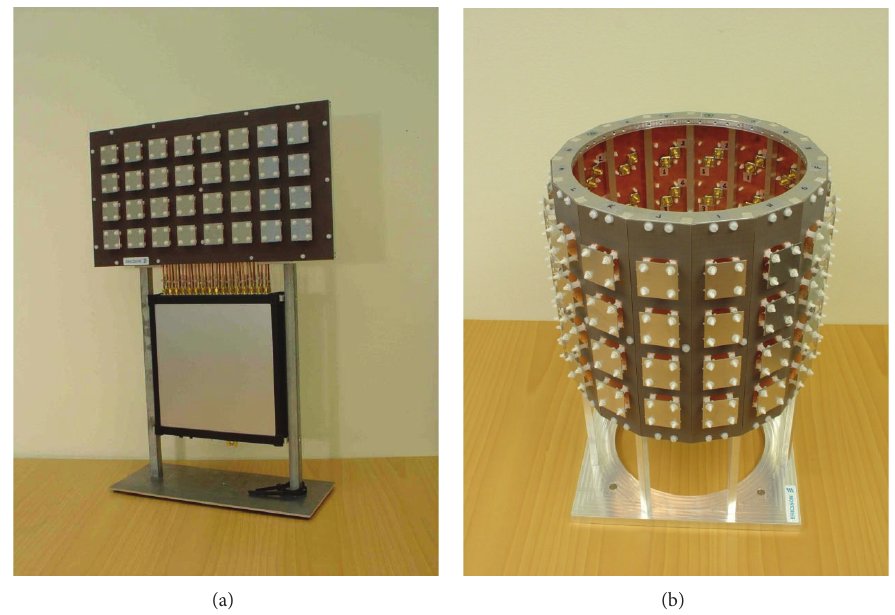
Figure 8: Transmitter antenna array and receiver antenna